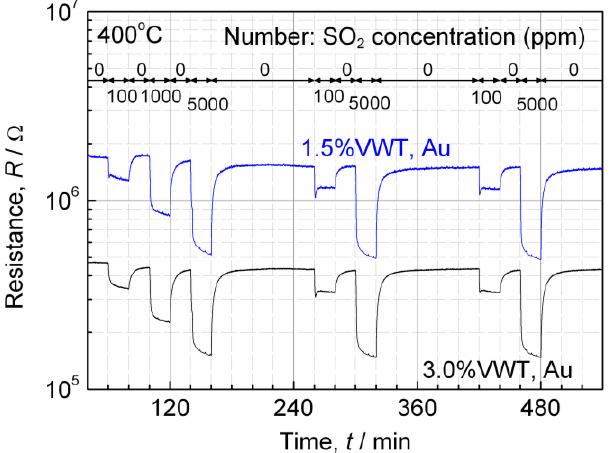
Figure 4. Repeated response for the sensors with Au electrodes at 400